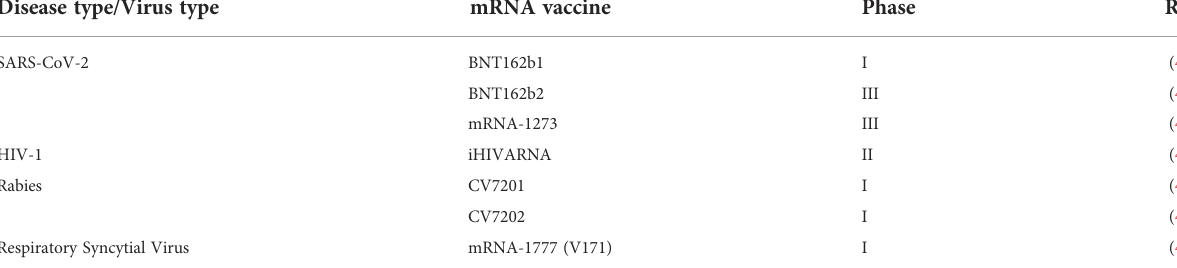
TABLE 1 Clinical trials of mRNA vaccines in infectious diseases. Disease type/Virus type